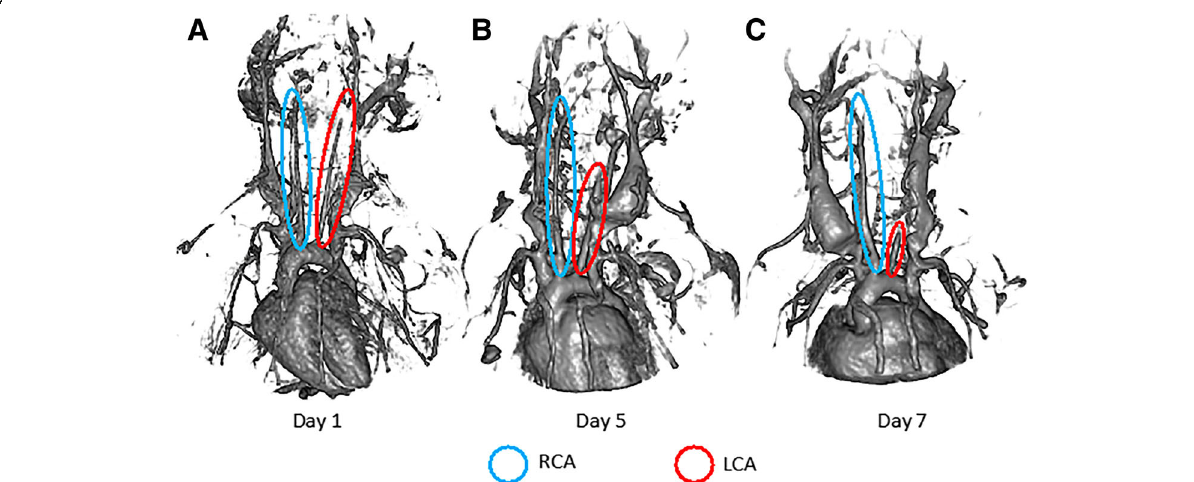
Fig. 1 Representative UTE MRI images generated from detection of ferumoxytol flowing through vessels of mice in the disturbed flow conditioned experimental cohort, with blue circles indicating the RCAs and red circles indicates the LCAs. a Shows ferumoxytol-marked vascular structure of mice at day 1 post-ligation surgery. b The structure of visible vasculature is identified, revealed by ferumoxytol contrast, after 5days post-ligation surgery. c The vascular integrity of the mouse after 7days post-LCA ligation surgery is shown, as indicated by ferumoxytol contrast. Over time, reduction of detectable ferumoxytol in of the LCA suggests minimal blood flow, which would correspond to lower shear stress along the wall of the LCA. Additionally, there appears to be progressive remodeling of LCA vessel diameter and surrounding vessels, suggesting an inflammatory response, which is to be confirmed in the present study